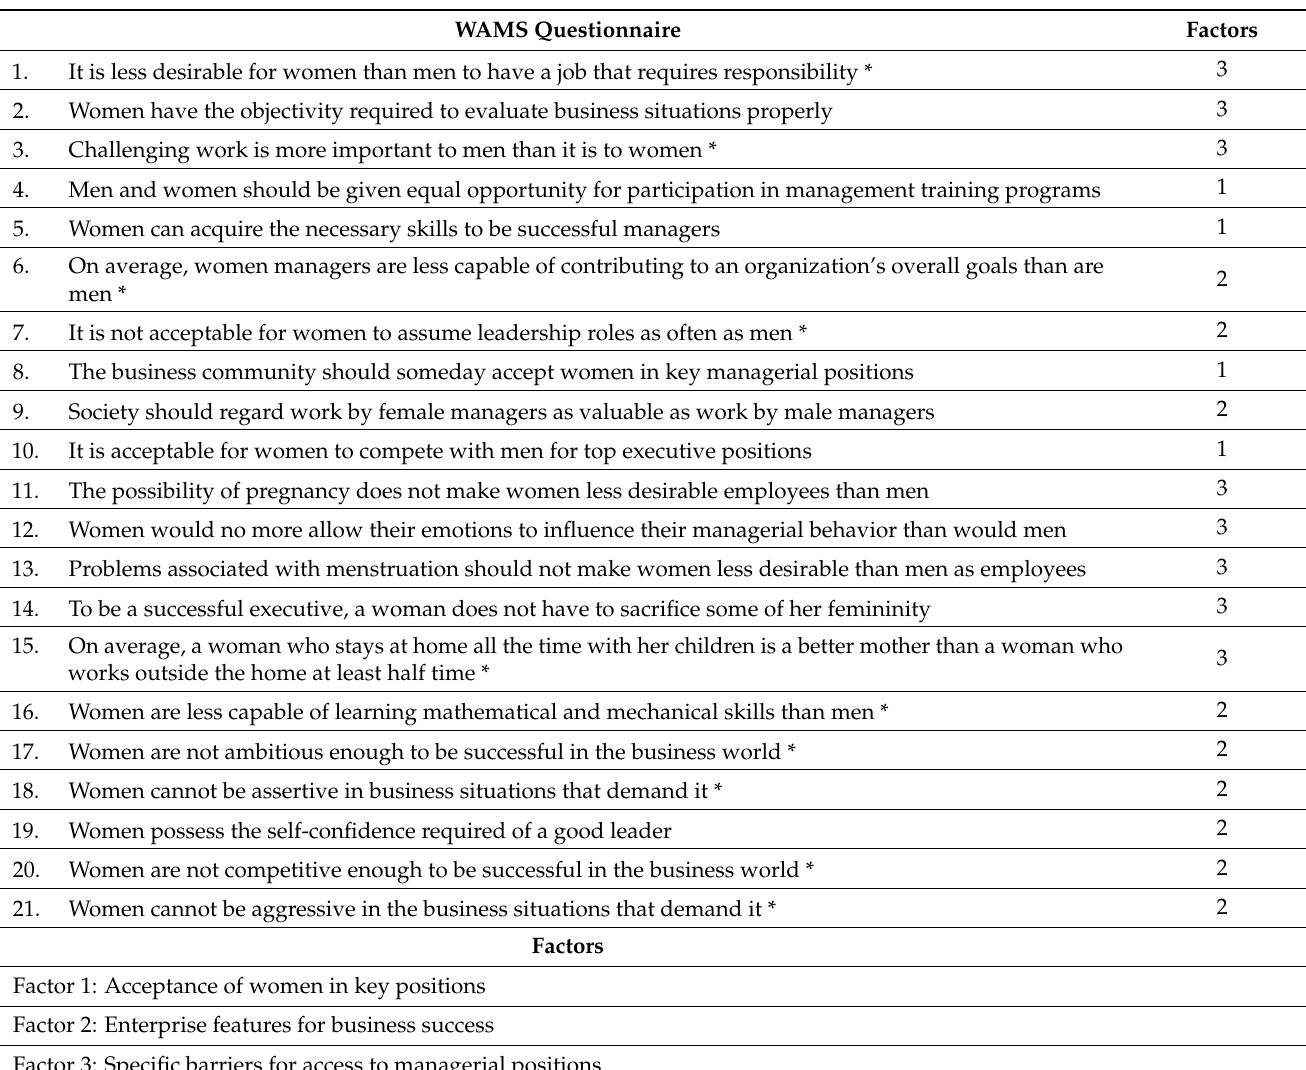
Table 1. Women As Managers Scale (WAMS)